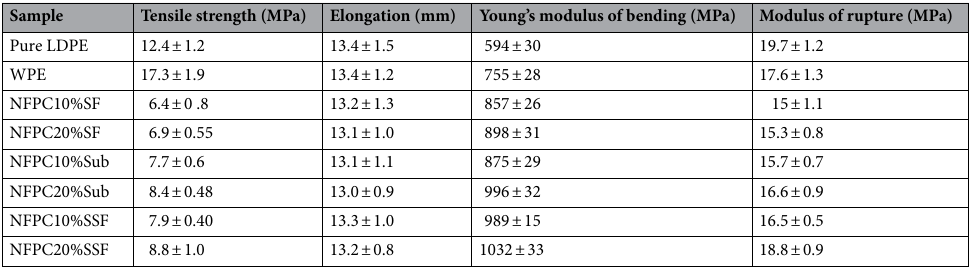
Table 2. Mechanical properties of the